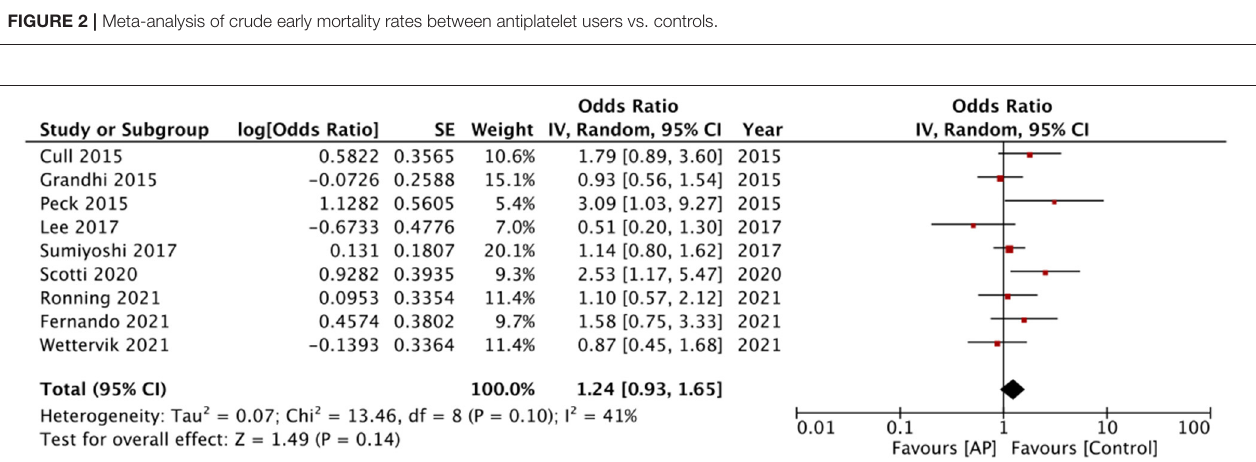
FIGURE 3 | Meta-analysis of adjusted early mortality rates between antiplatelet users vs.